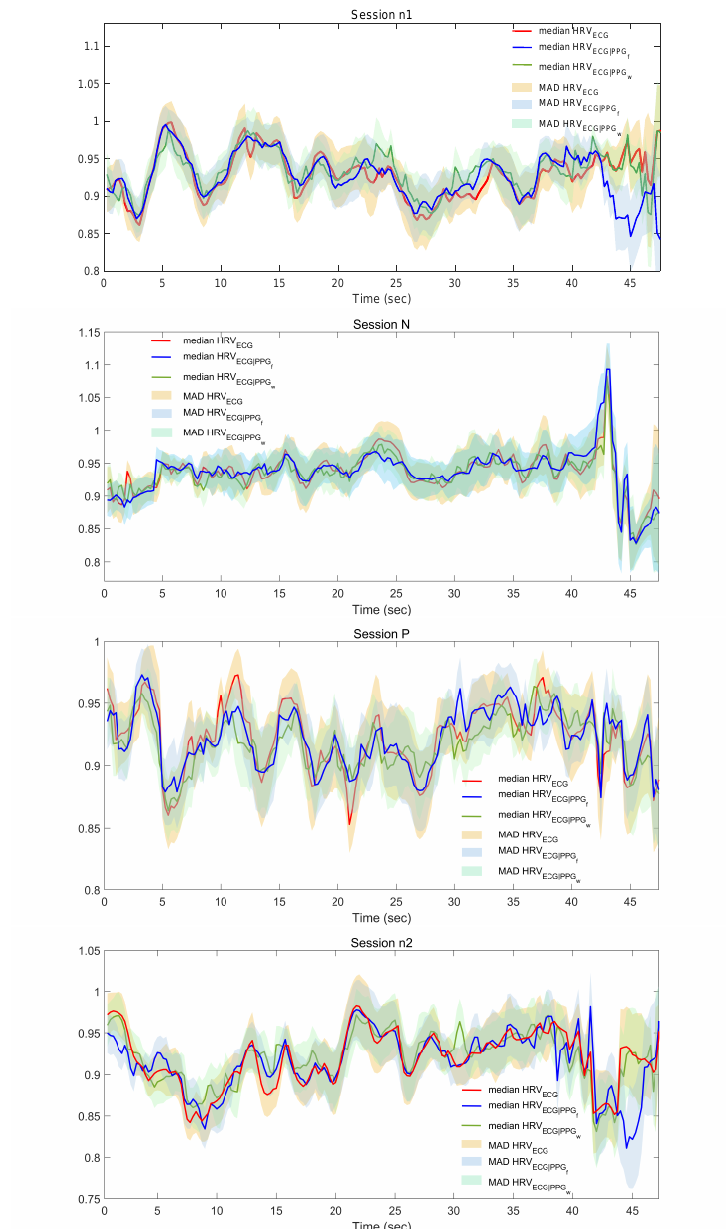
Figure 3. Trends of median and median absolute deviation (MAD) values of HRV ECG , HRV ECG | PPG HRV ECG | PPG as a function of the time for each experimental session (n1, N, P, n2). The time duration w of the graphs is less than 60 s because by applying the cross-mapping (CM) method we are unable to reconstruct the last part of the signal (the points in the reconstructed phase space are n − ( E − 1 ) τ